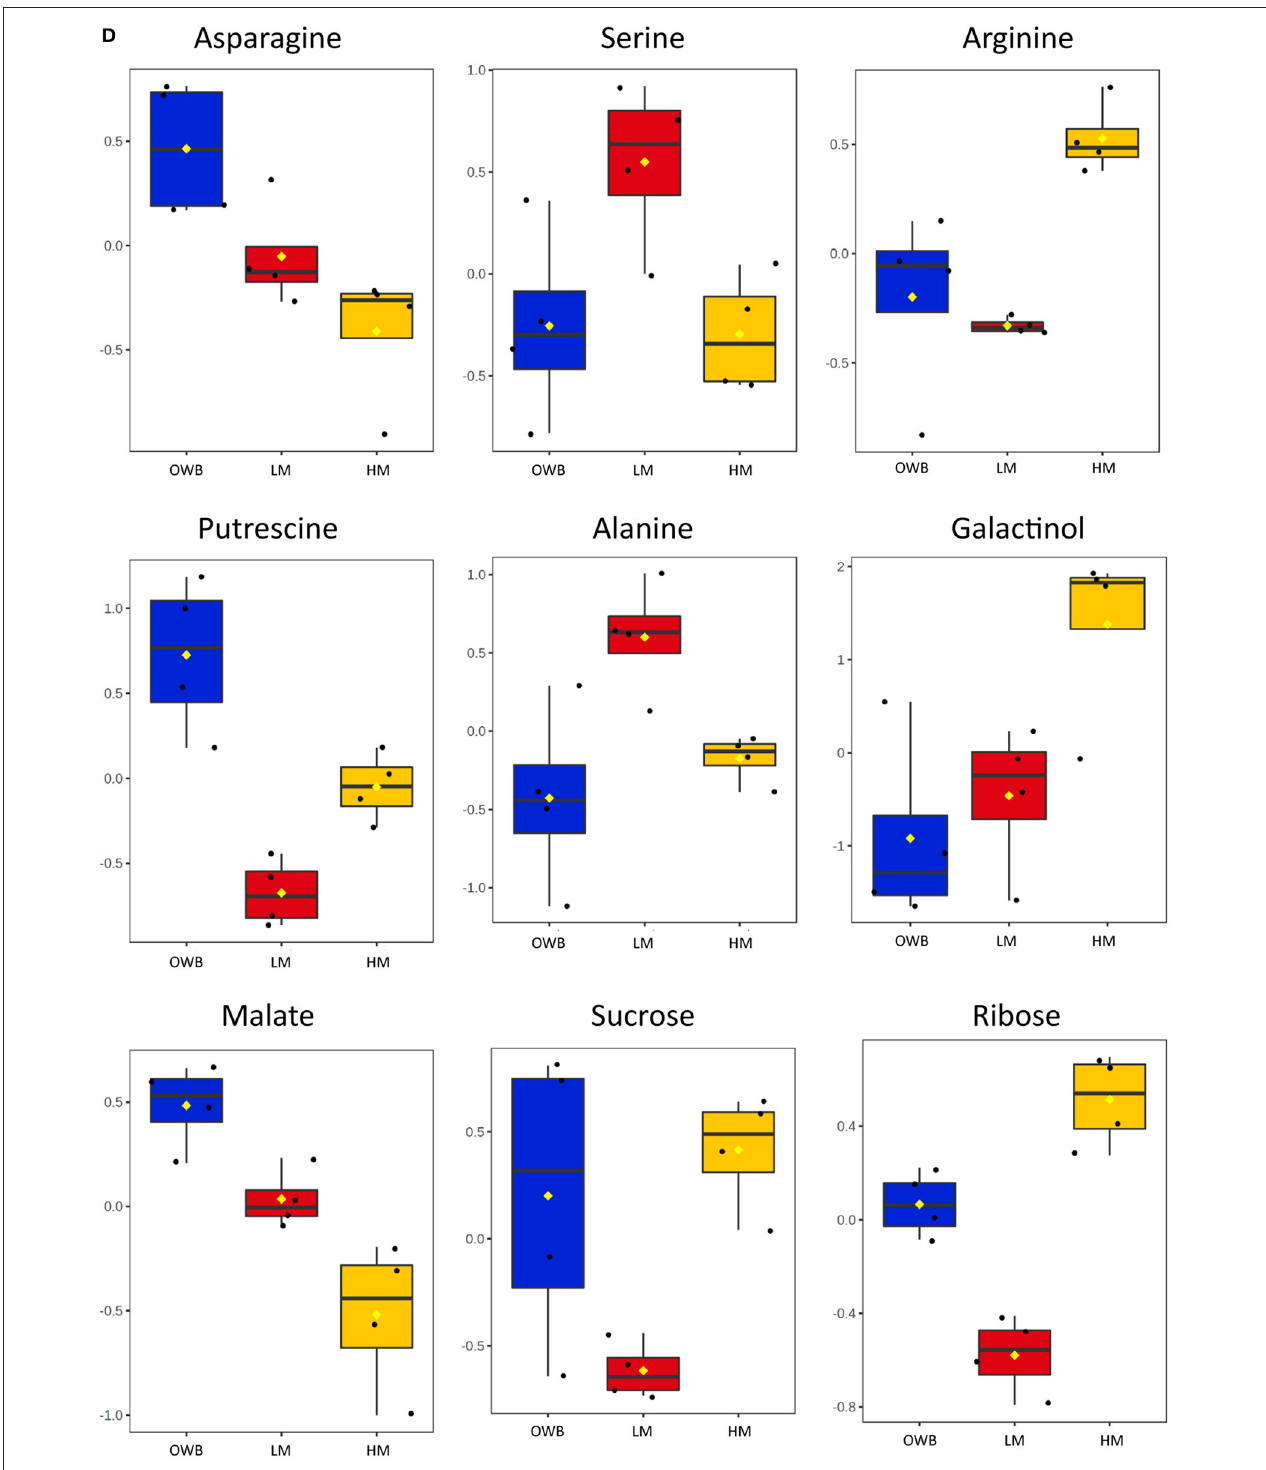
FIGURE 6 | Selected metabolites from the xylem sap of plants cultivated with different fertilizers. Identification is performed in MSDIAL, statistics performed with MetaboAnalyst 5.0 (https://www.metaboanalyst.ca/). Concentrations are shown as log-transformed and normalized mean values. (A,B) : Unsupervised and supervised analysis of xylem sap composition, where (A) is principal component analysis (PCA) loading plot and (B) is sPLS-DA loading plot. (C) : Heatmap of 50 most significant metabolites based on ANOVA test. (D) : Fold change in selected metabolites for three treatments, n = 4. OWB, Organic waste-based; LM, Low-mineral; HM, High-mineral